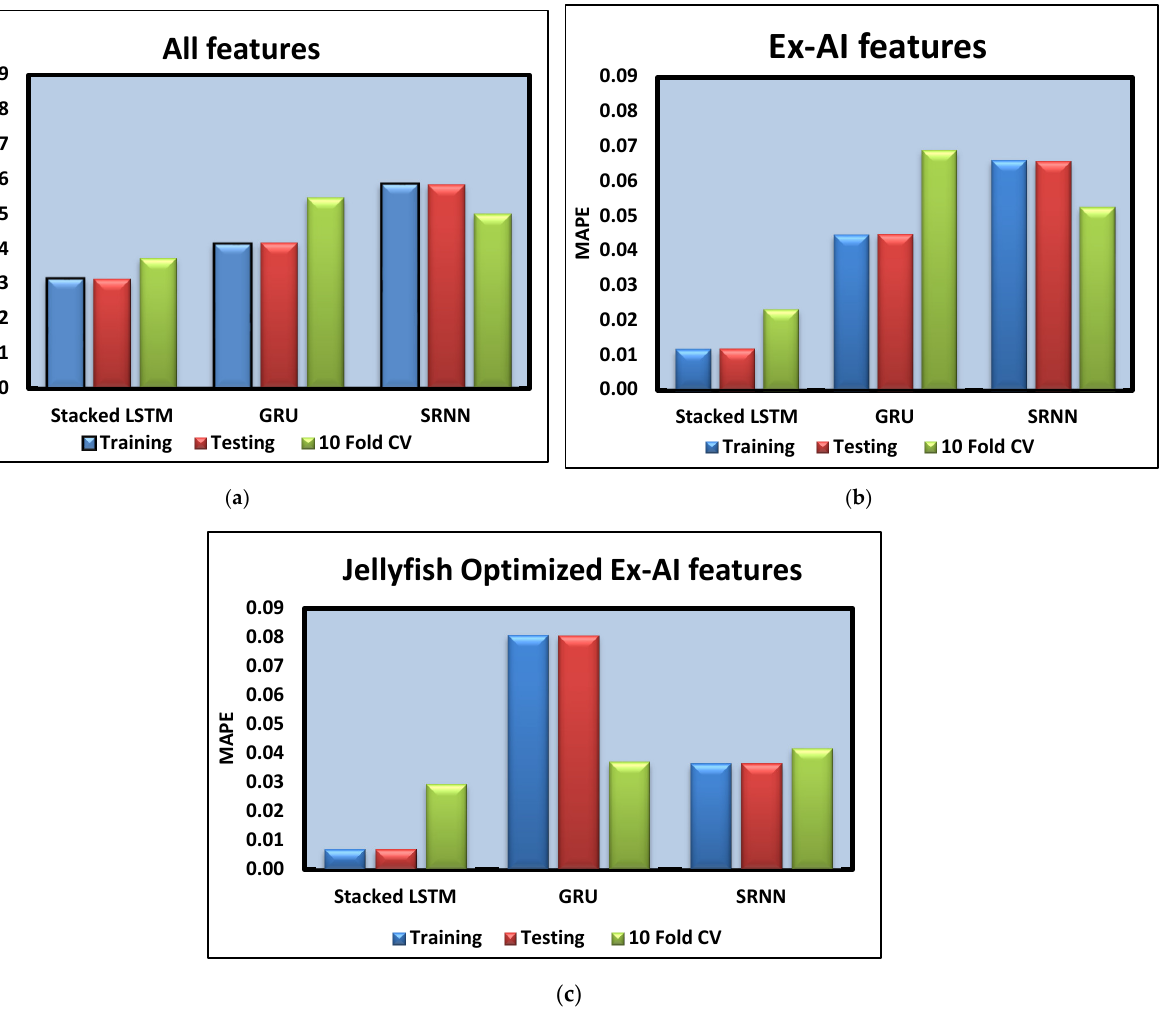
Figure 13. ( a – c ) MAPE values from three models. ( a ) All features. ( b ) Ex-AI features. ( c ) Jellyfish- optimized Ex-AI features.